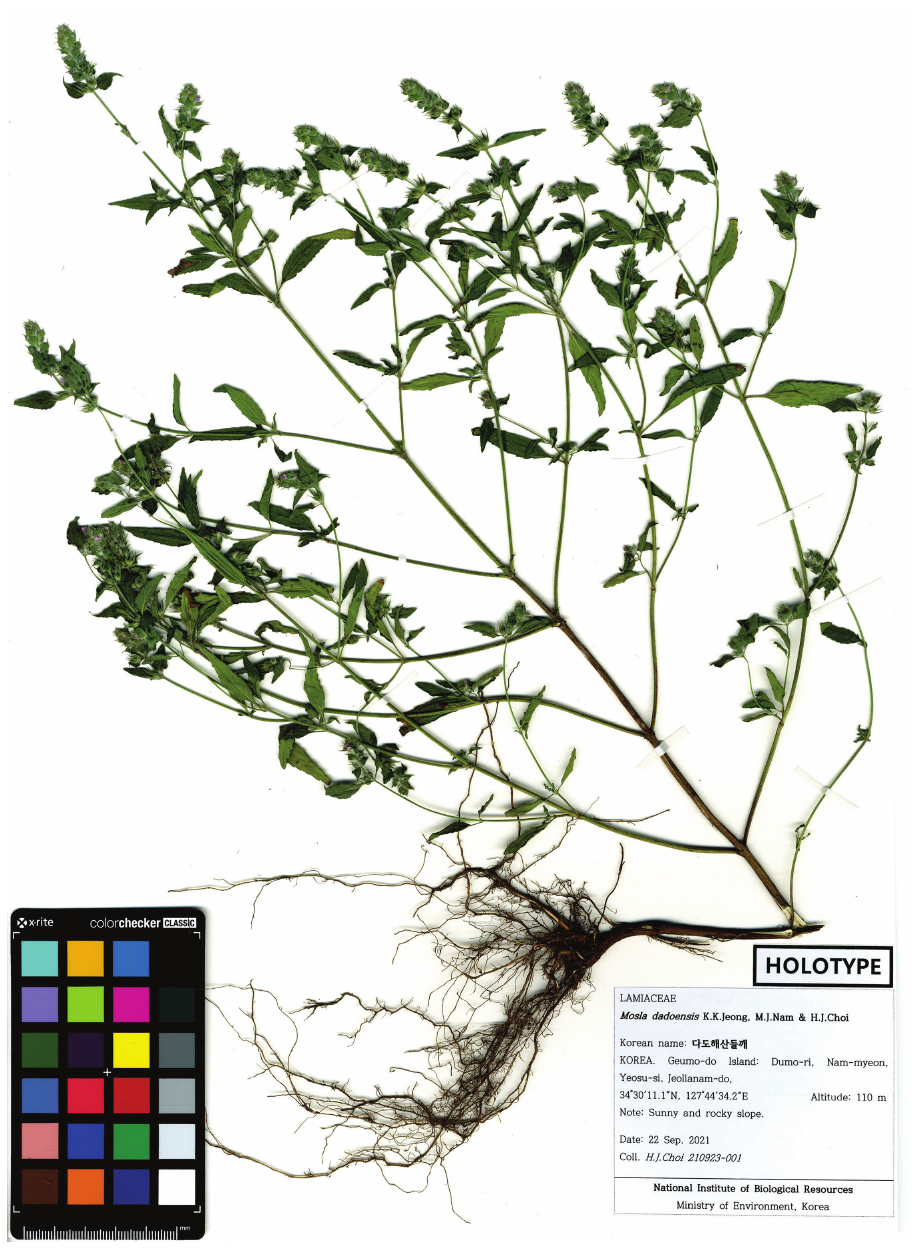
Figure 2. Photograph of the holotype of Mosla dadoensis